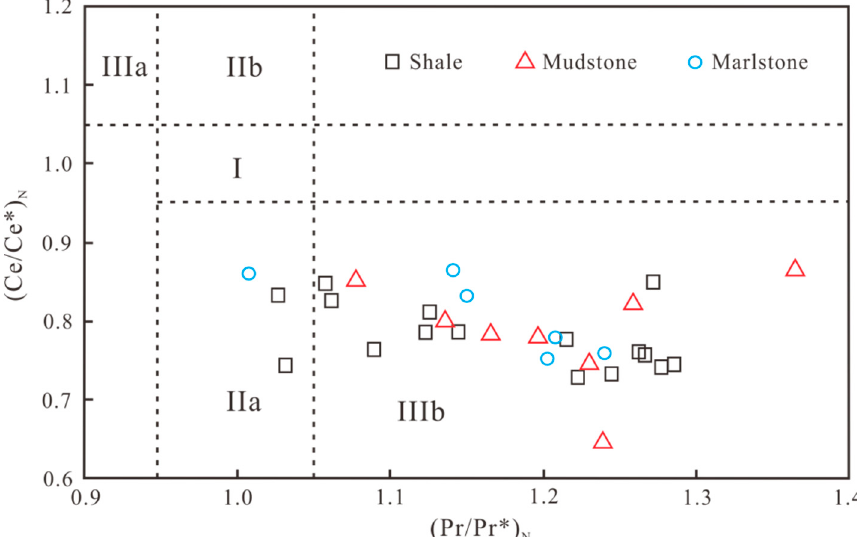
Figure 7. Cross plots demonstrating the relationship between Pr/Pr ∗ against Ce/Ce ∗ for 30 black rock series samples from Zhenning section. Base map modified from [25]. Notes: (a) Field I: neither La anomaly nor Ce anomaly; (b) Field IIa: positive La anomaly, no Ce anomaly; (c) Field IIb: negative La anomaly, no Ce anomaly; (d) Field IIIa: positive Ce anomaly; (e) Field IIIb: negative Ce anomaly. Except for four samples (ZN-14, ZN-15, ZN-28, and ZN-29) that have slightly positive